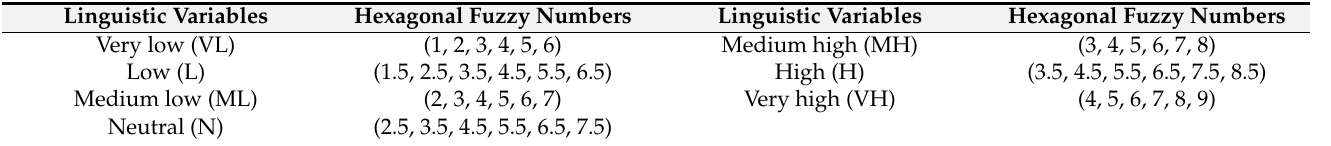
Table 6. Linguistic terms and their corresponding HFN.